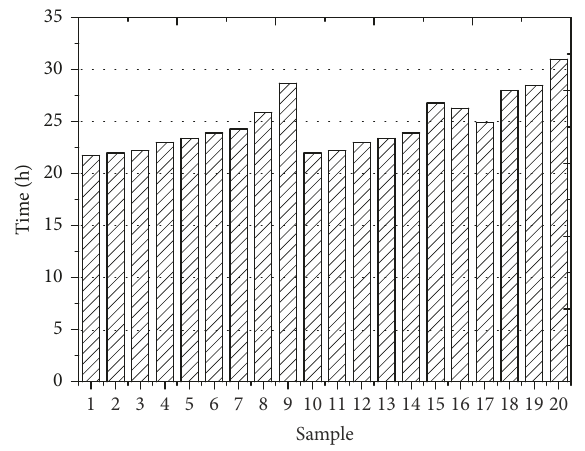
Figure 9: The autogenous shrinkage of references with